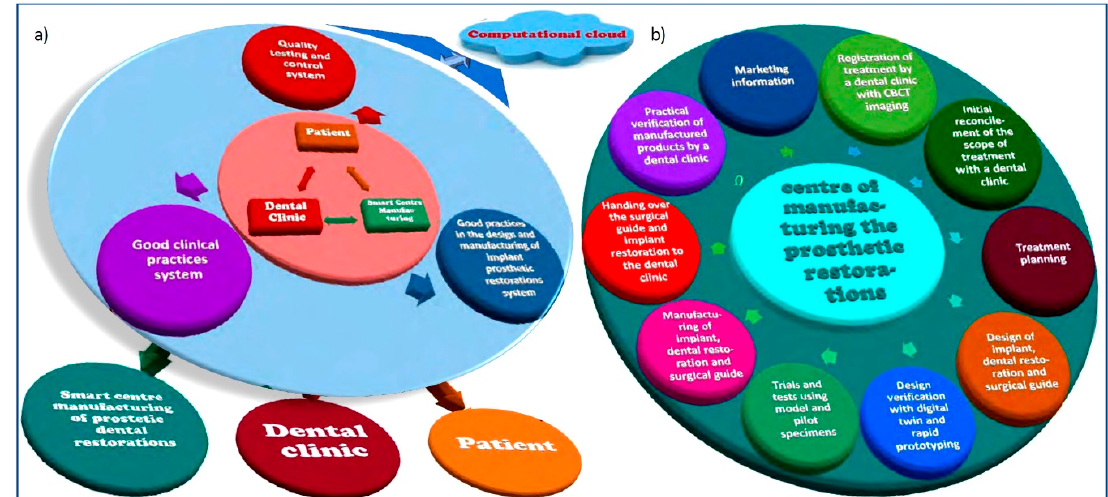
Figure 21. Diagram ( a ) relationship between the patient’s expectations, design, and manufacturing capabilities of the center for the manufacture of dental prosthetic restorations and ( b ) the medical tasks of a dental clinic according to the concept of Dentistry 4.0.